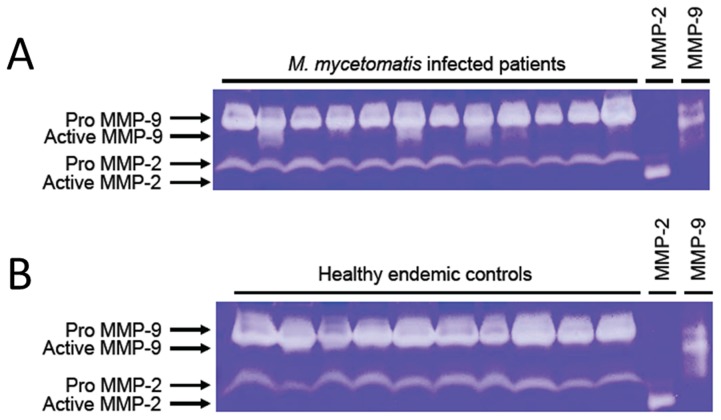
MMP activity in sera of M. mycetomatis infected patients and healthy endemic controls as demonstrated by gelatine zymography.One µl of serum of each subject was analyzed for MMP activity. Representative gelatine zymograms of 12 M. mycetomatis infected subjects (A) and 10 healthy endemic controls (B) are shown. The pro-active and active forms of MMP-2 and MMP-9 are marked with arrows. MMP-2: Activated proenzyme MMP-2; MMP-9: Activated proenzyme MMP-9.